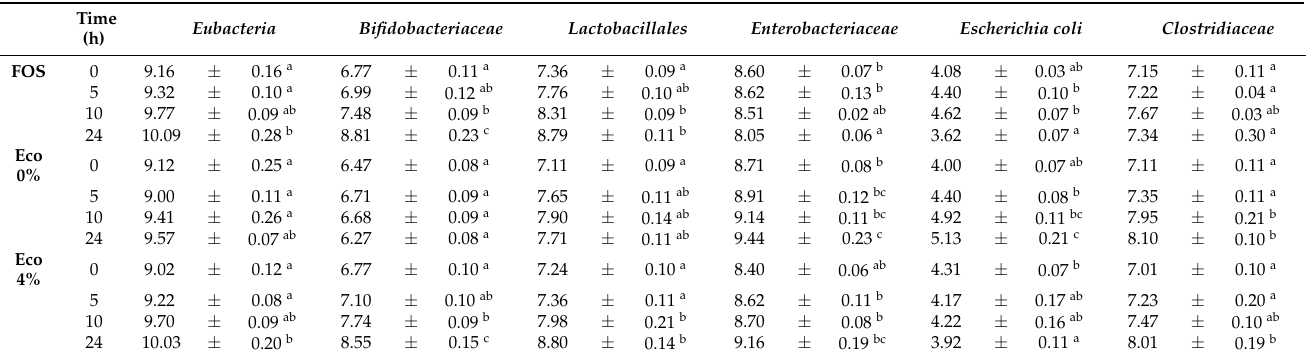
Table 2. Changes in bacterial populations measured by qPCR on a RotorGene 6000 (Qiagen, Hilden, Germany) with the SYBR Green I chemistry, expressed as mean values in Log 10